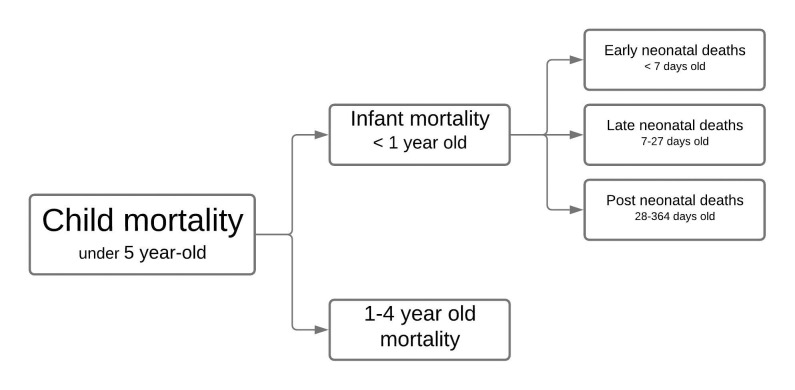
Child mortality components.